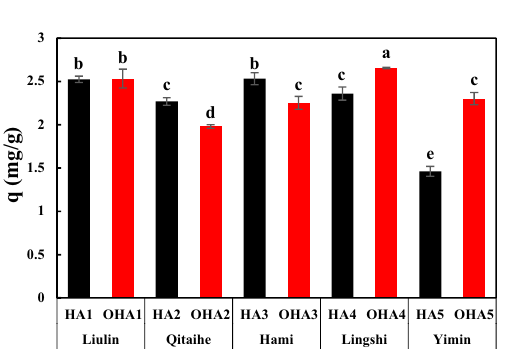
Figure 6. Nitrogen adsorption of HAs, HA1–HA5, the HAs extracted from original coal (black); OHA1– OHA5, the HAs extracted from oxidized coal (red); Liulin, Qitaihe, Hami, Lingshi and Yimin, the origin of coal.